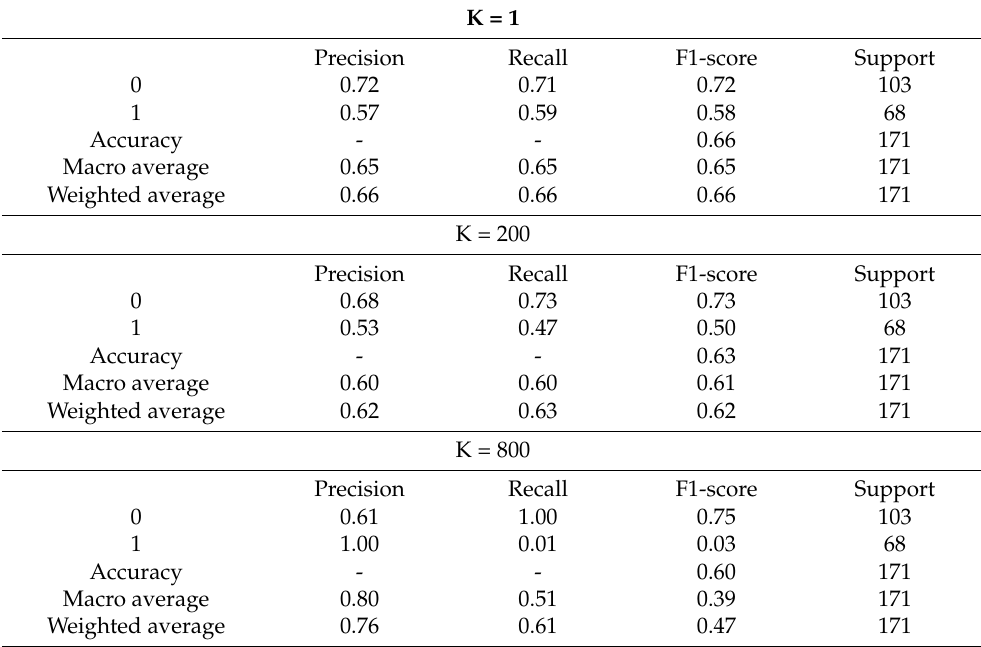
Table 3. Results analysis for different K values.